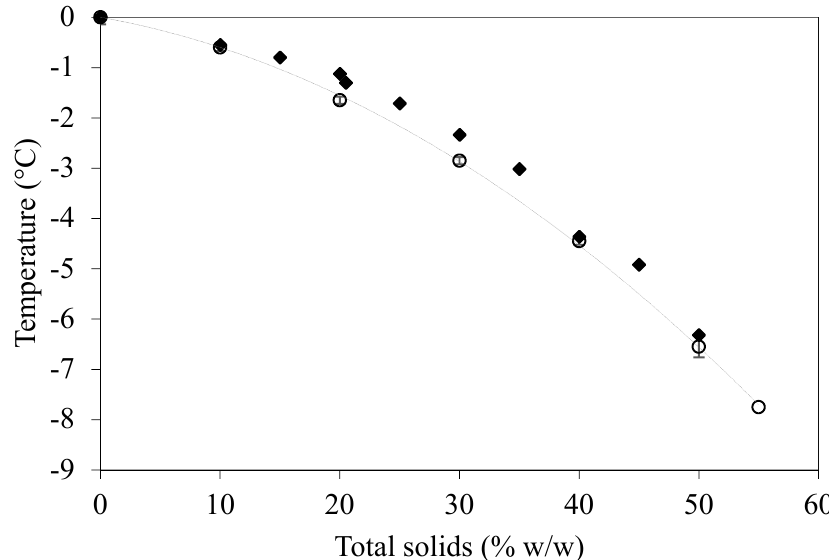
Figure 3. Melting line of the coffee solution, where ○ shows the melting temperature as a function of coffee concentration derived in this study and ◆ shows the melting curve for soluble coffee measured in [26].